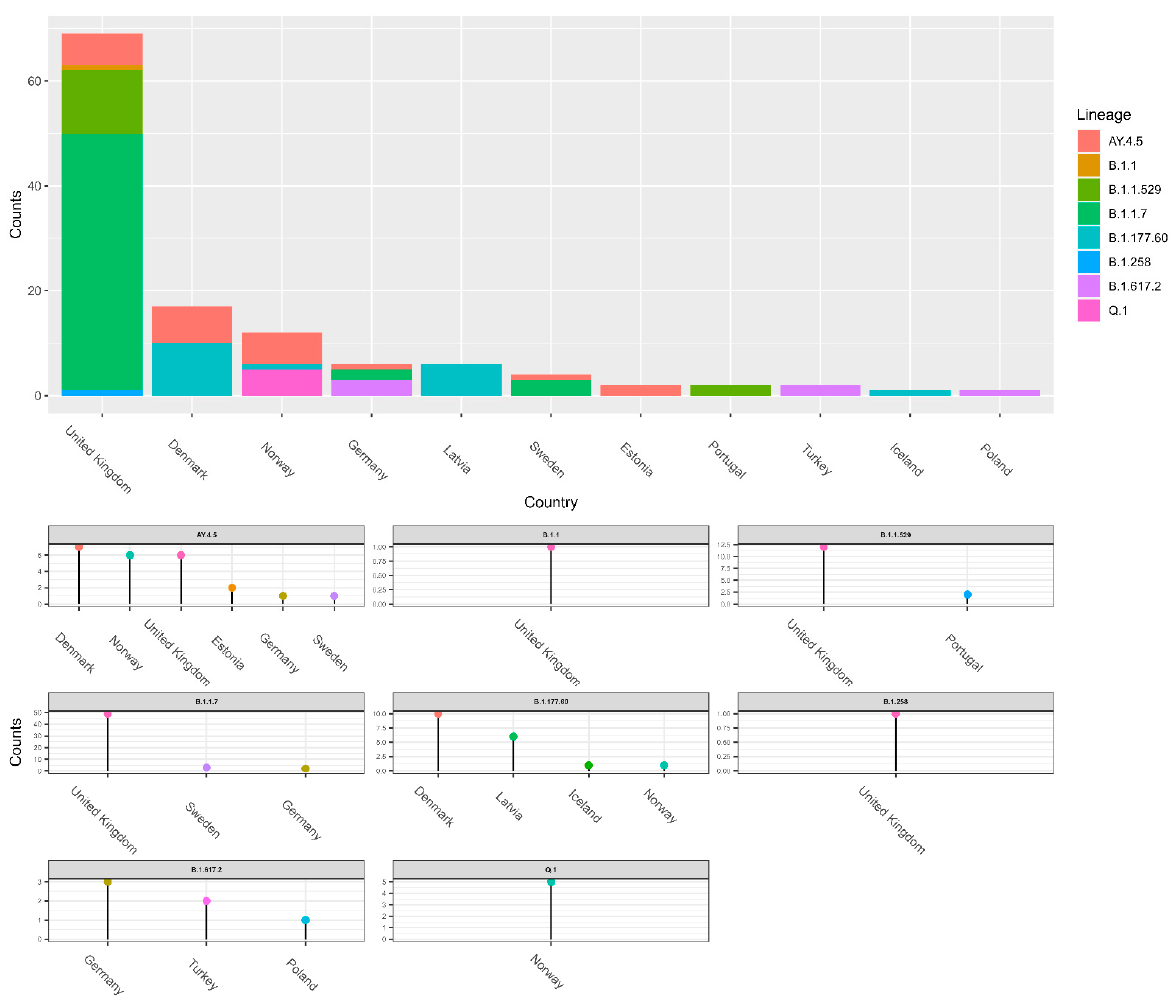
Figure A1. The Most likely countries of origin for the most prevalent lineages based on transmission clusters. The Y axis depict frequency of transmission as to Lithuania from the enlisted countries, as inferred from the phylogenetic trees. The upper graph depicts the cumulative counts of transmission across different lineages. The small graphs below give details of the top four countries with the largest observed transmission counts to Lithuania .